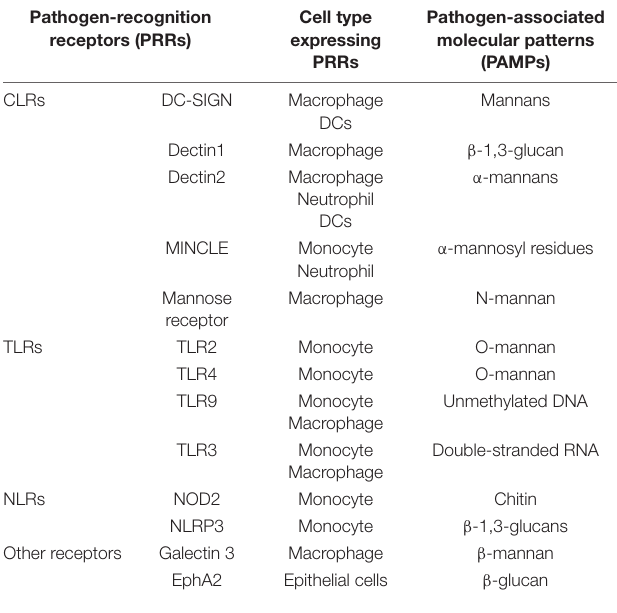
TABLE 1 | Pattern recognition receptors that sense fungal-associated